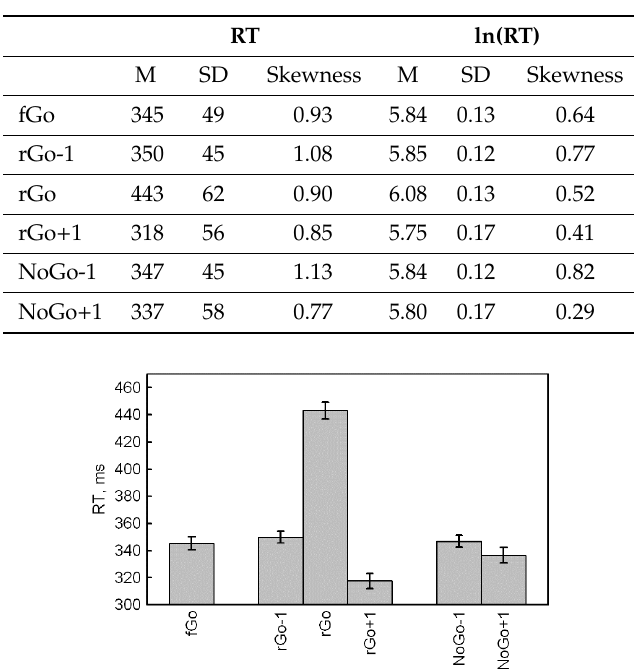
Table 1. Reaction times for frequent and rare Go stimuli.